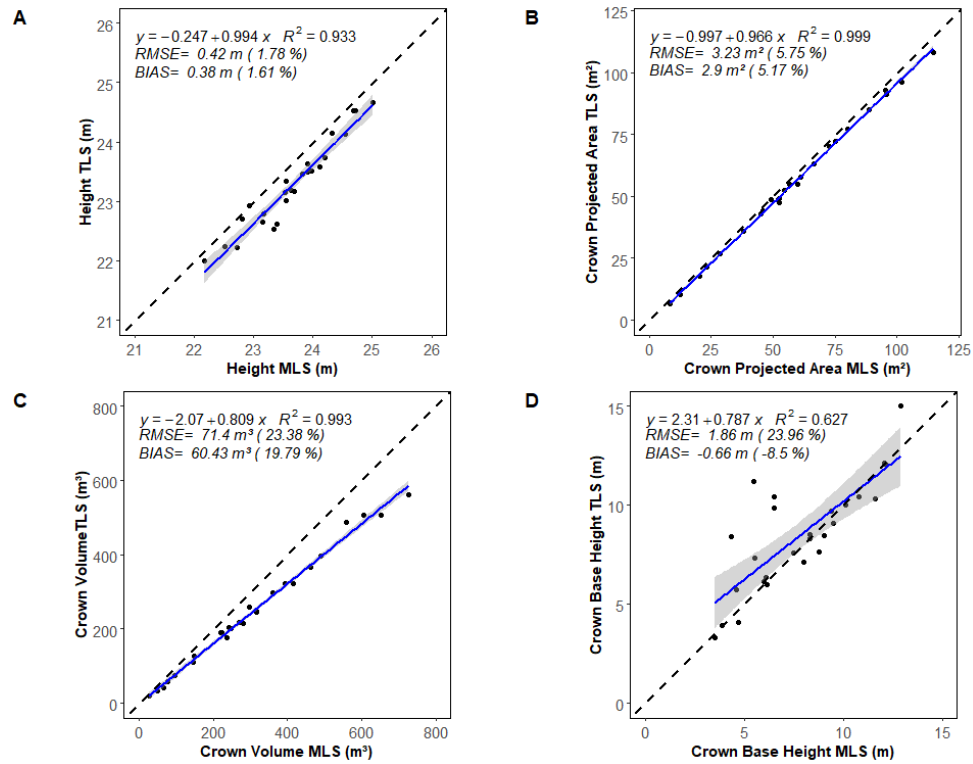
Figure 7. Comparison of ( A ) tree height (H); ( B ) crown projected area (CPA); ( C ) crown volume (CV) and ( D ) crown base height (CBH) for the 26 TLS and MLS trees. The blue line represents the linear regression. The grey zone is the 95% confidence band for predictions. The dashed black line represents the 1:1 line. In comparison to field measurements, TLS and MLS data show similar reliable DBH estimates, with a negative bias of 1.53 cm and 2.49 cm, respectively (Figure 8A,B). The strong relationship between DBH, estimated by TLS and MLS data ( R 2 = 0.99; RMSE = 1.21 cm (3.07%), Figure 8C), shows that, despite MLS data being noisier, the circle ‐ fitting method gave very similar results for TLS and MLS point clouds.